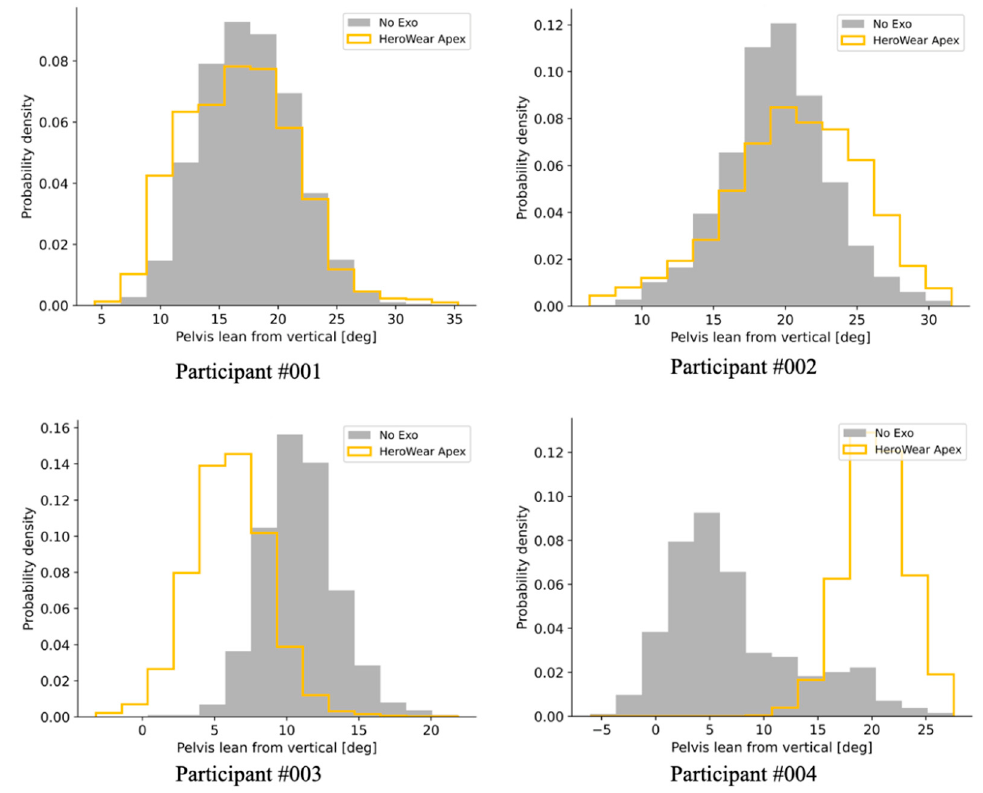
Figure 8. Histograms of pelvis lean from vertical for pushing the unloaded gondola at level ground.